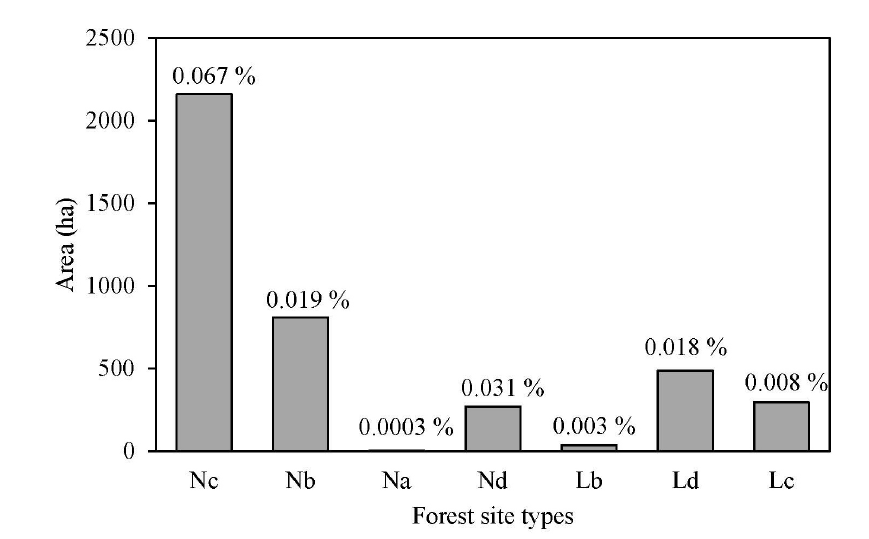
Figure 3. Distribution of Sambucus sp. in different sites respect to the area (ha) and proportion in percentage of total site types. Abbreviations for the degree of soil humidity are: N, fresh soils; L, moisture soils; abbreviations for the degree of soil fertility are: a, very poor; b, poor; c, fertile; d, very fertile.